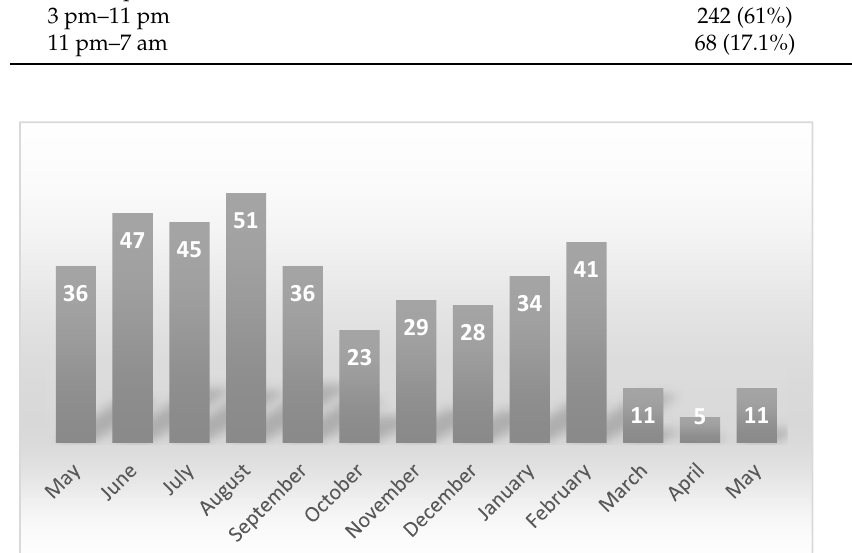
Figure 1. Most injuries were produced during summer months. A decrease in the number of injuries can be observed during the COVID ‐ 19 lockdown period.